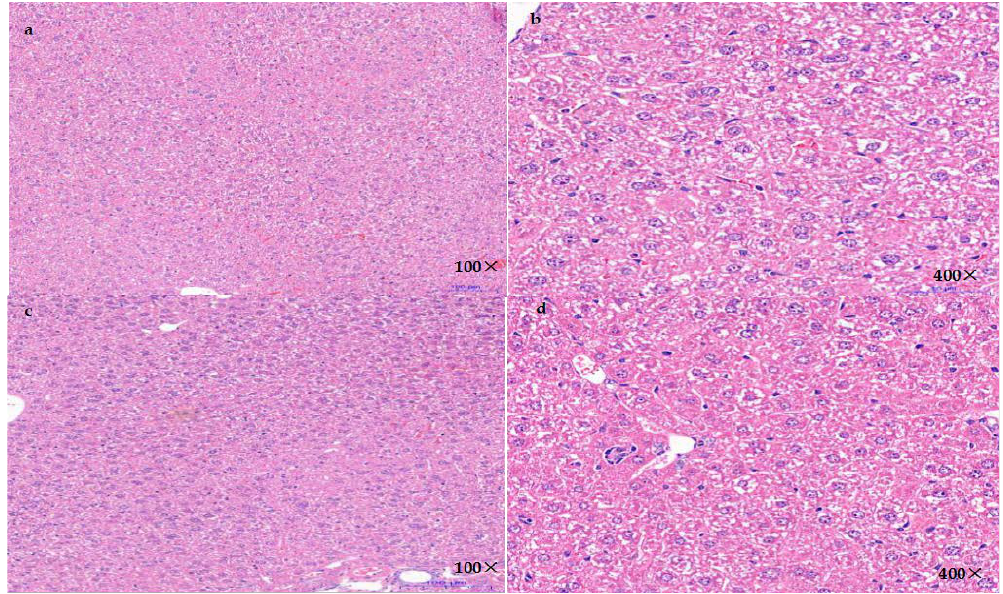
Figure 3. Pathological sections of liver tissues from mice. ( a ) control group(magnification 100×); ( b ) control group(magnification 400×); ( c ) experimental group(magnification 100×); ( d ) experimental group(magnification 400×).